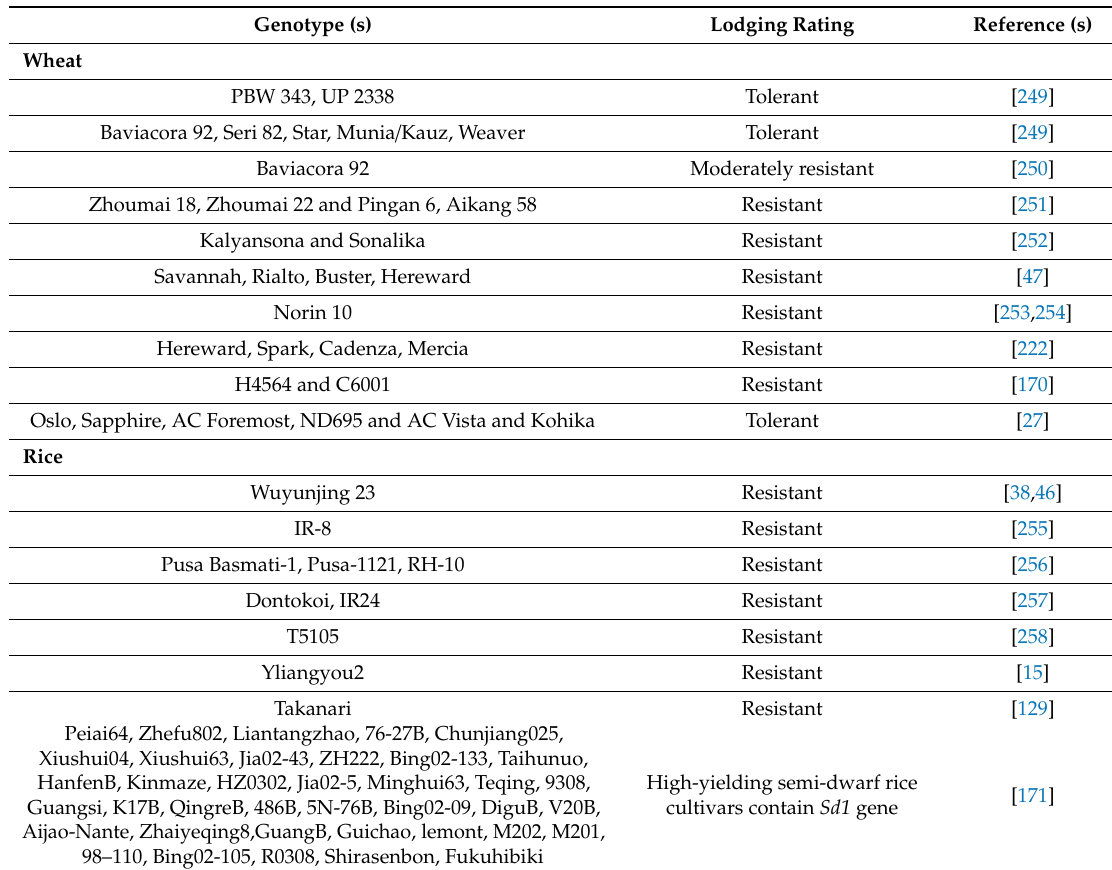
Table 4. Wheat and rice genotypes along with lodging vulnerability